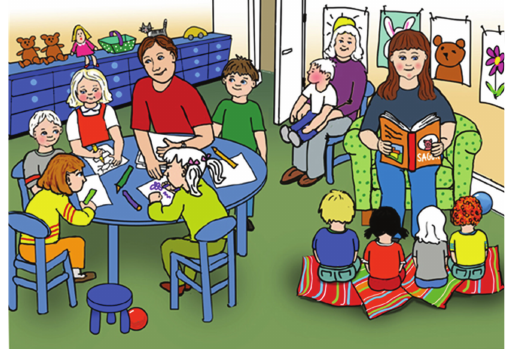
Figure 3: At preschool. Illustrations by Gunilla W¨arnstr¨om.